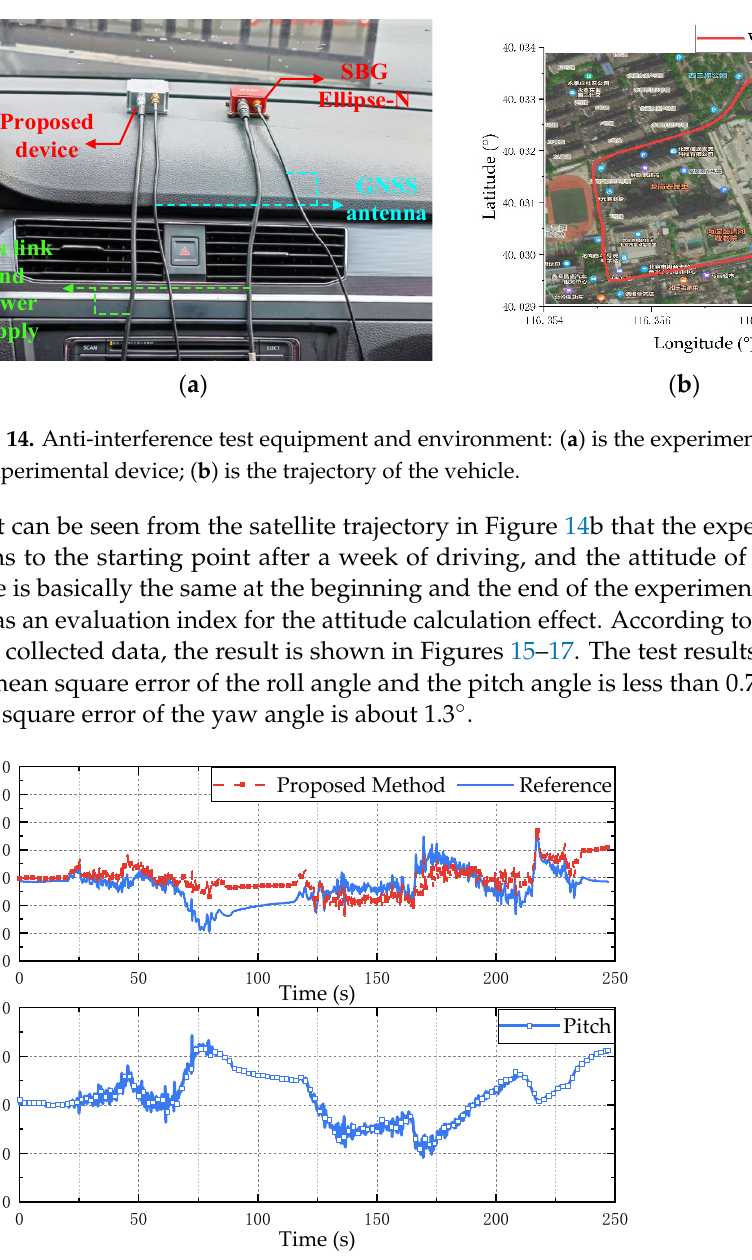
Figure 16. Roll angle anti-interference test results. The above is the estimation result of the proposed method, and the bottom is the error between the estimated value and the reference value. Figure 17. Yaw angle anti-interference test results. The above is the estimation result of the proposed method, and the bottom is the error between the estimated value and the reference value.